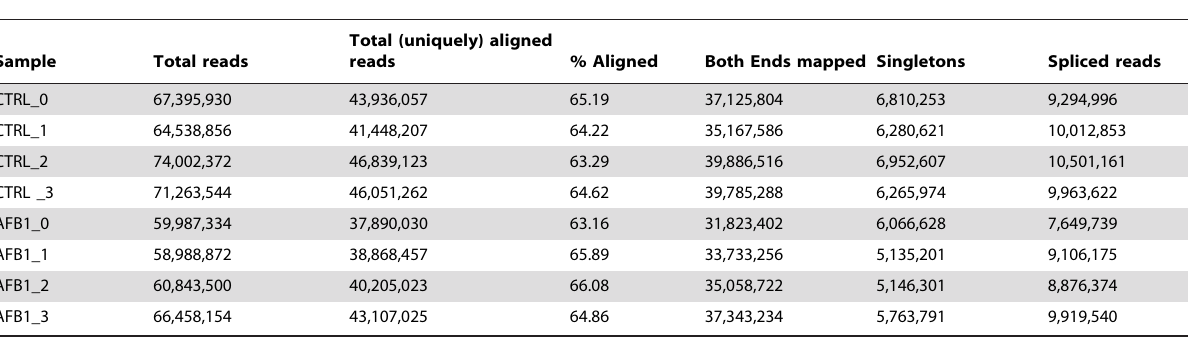
Table 1. Alignment of RNA-Seq Reads to the Rat Genome a .